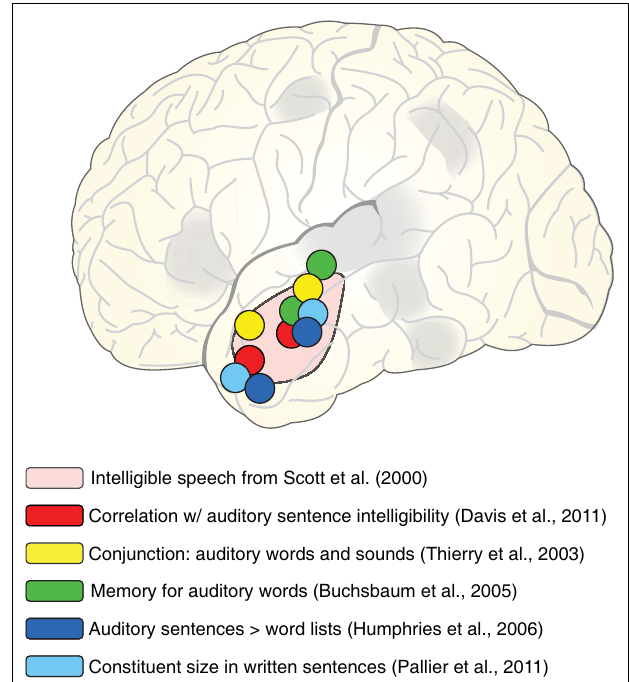
FIGURE 8 | Schematic illustration of peaks from various fMRI studies in which activation of left anterior lateral temporal cortex was observed, overlaid on the region showing sensitivity to speech intelligibility from Scott et al.